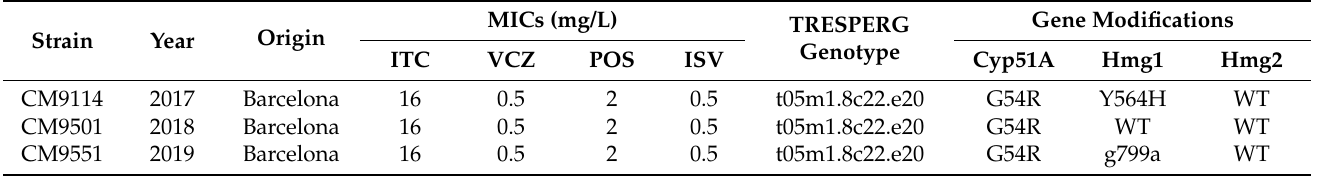
Table 5. A. fumigatus isogenic clinical isolates obtained from three independent patients with same MIC profile but different Hmg1